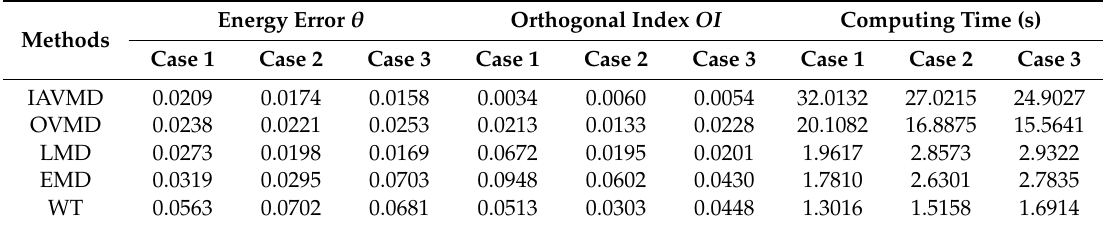
Table 3. The quantitative comparisons among di ff erent approaches in the experiment signal.